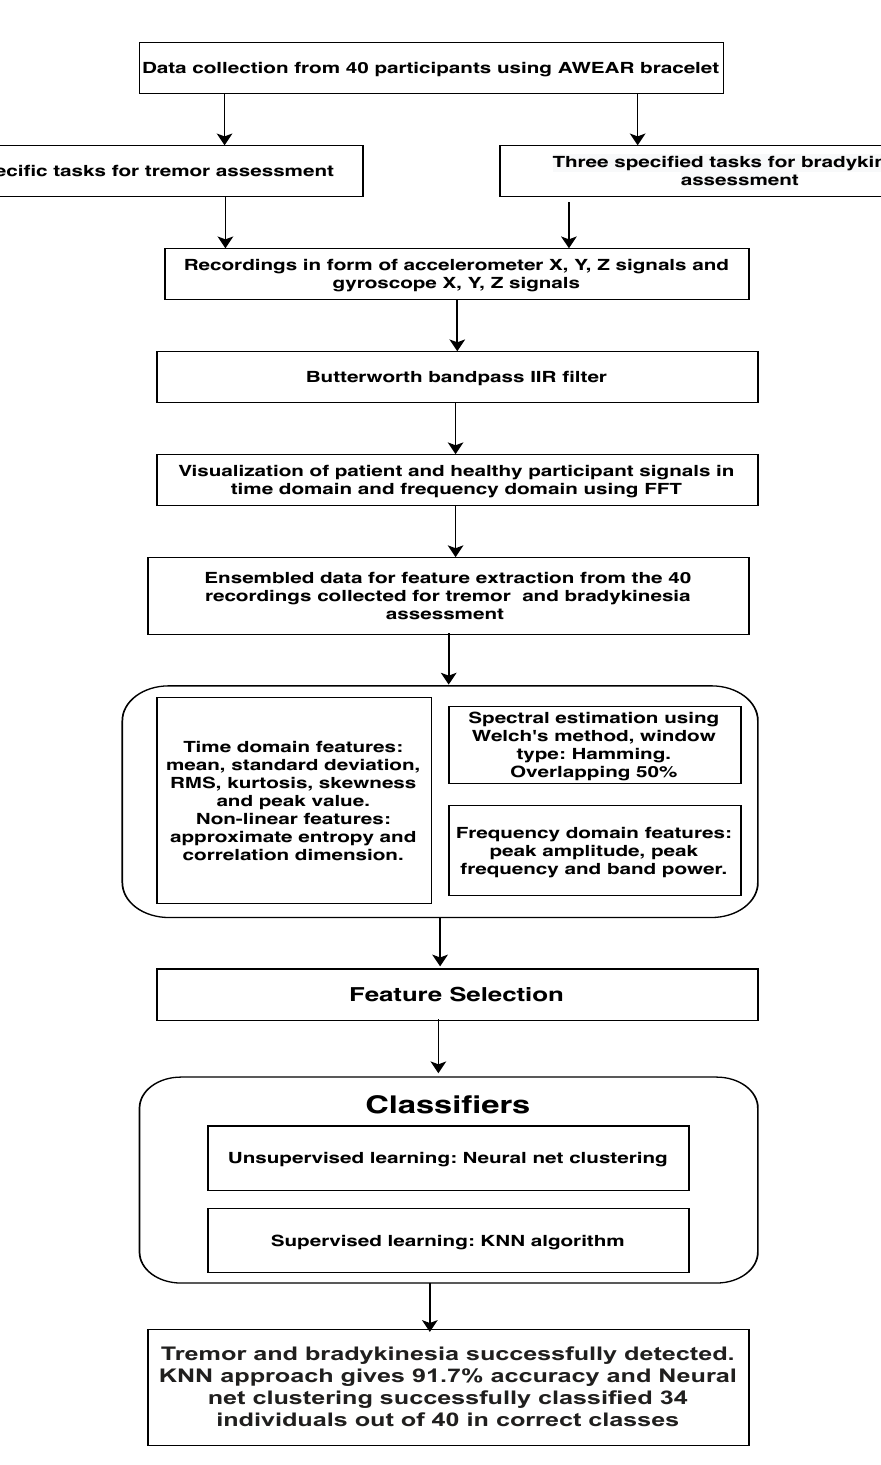
Figure 4. Illustration of the whole process for detection of tremor and